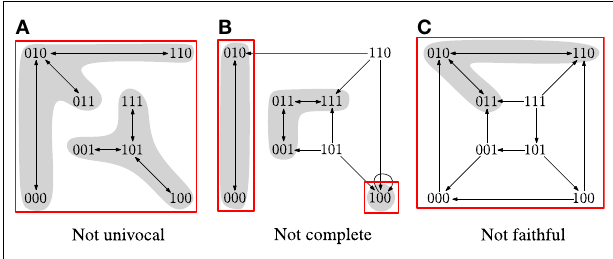
FIGURE 1 | The asynchronous STGs of three different Boolean networks . The minimal trap spaces are indicated by boxes. (A) Two attractors in the same box. (B) An attractor outside of the boxes. (C) An attractor that does not oscillate in all dimensions of the box. Equations for the networks are given in the Supplementary